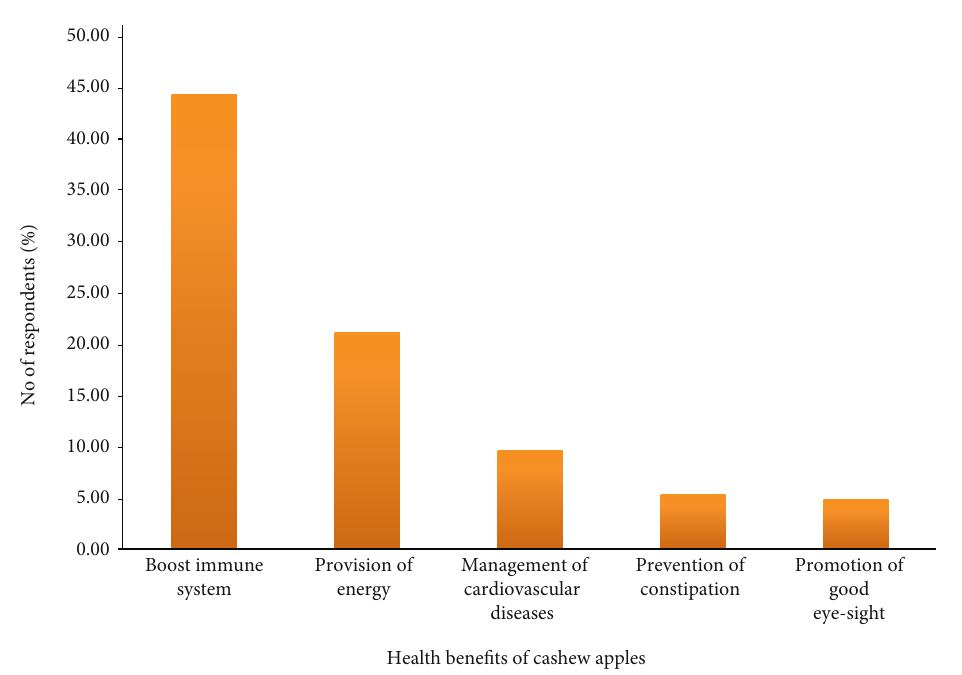
Figure 1: Cashew stakeholders ’ knowledge about health bene fi ts of cashew apples. Note: others refer to responses outside the thematic